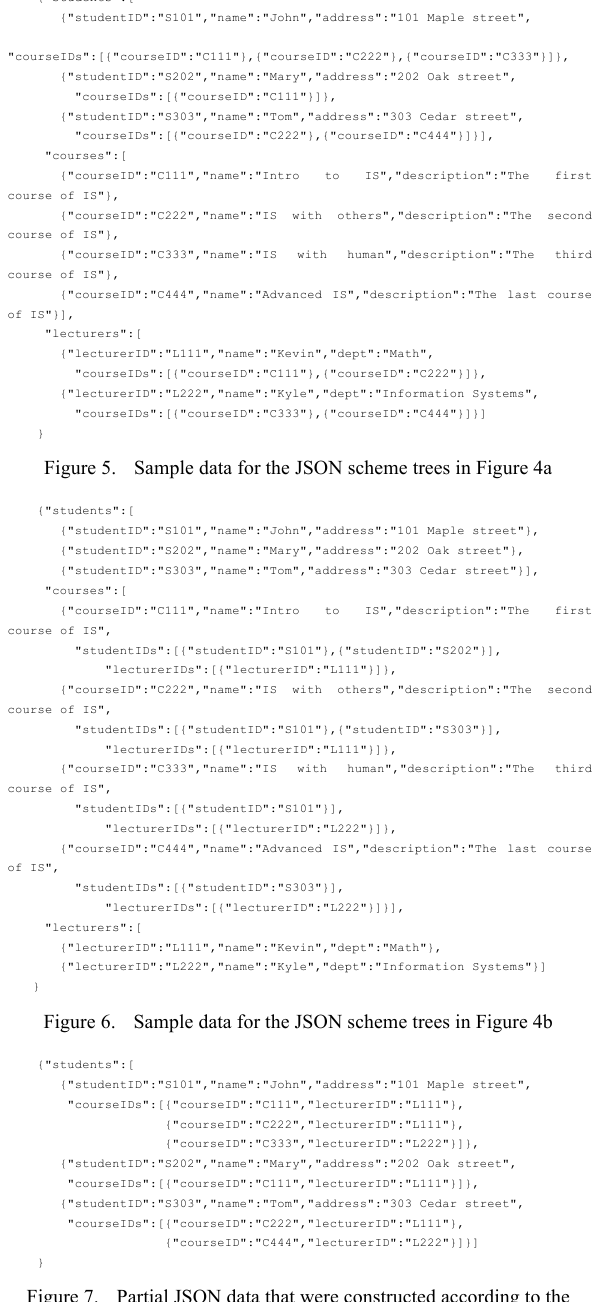
Figure 7. Partial JSON data that were constructed according to the JSON scheme trees in Figure